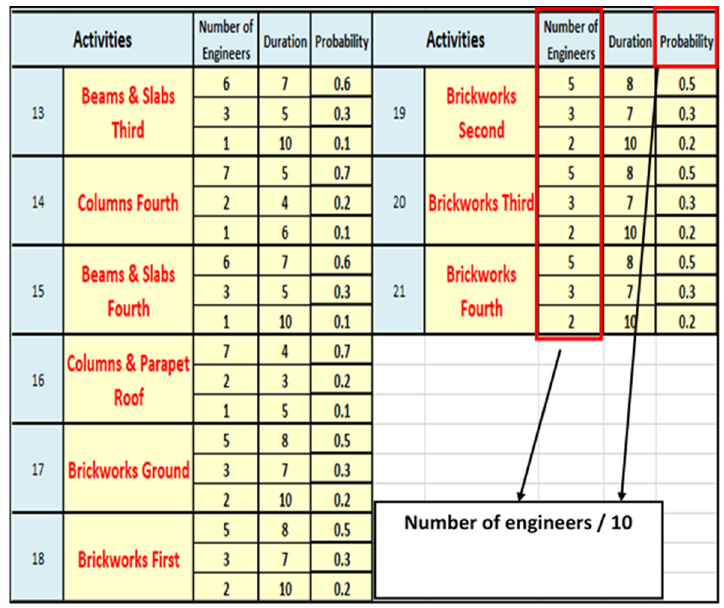
Figure 13. Analysis of the survey results.